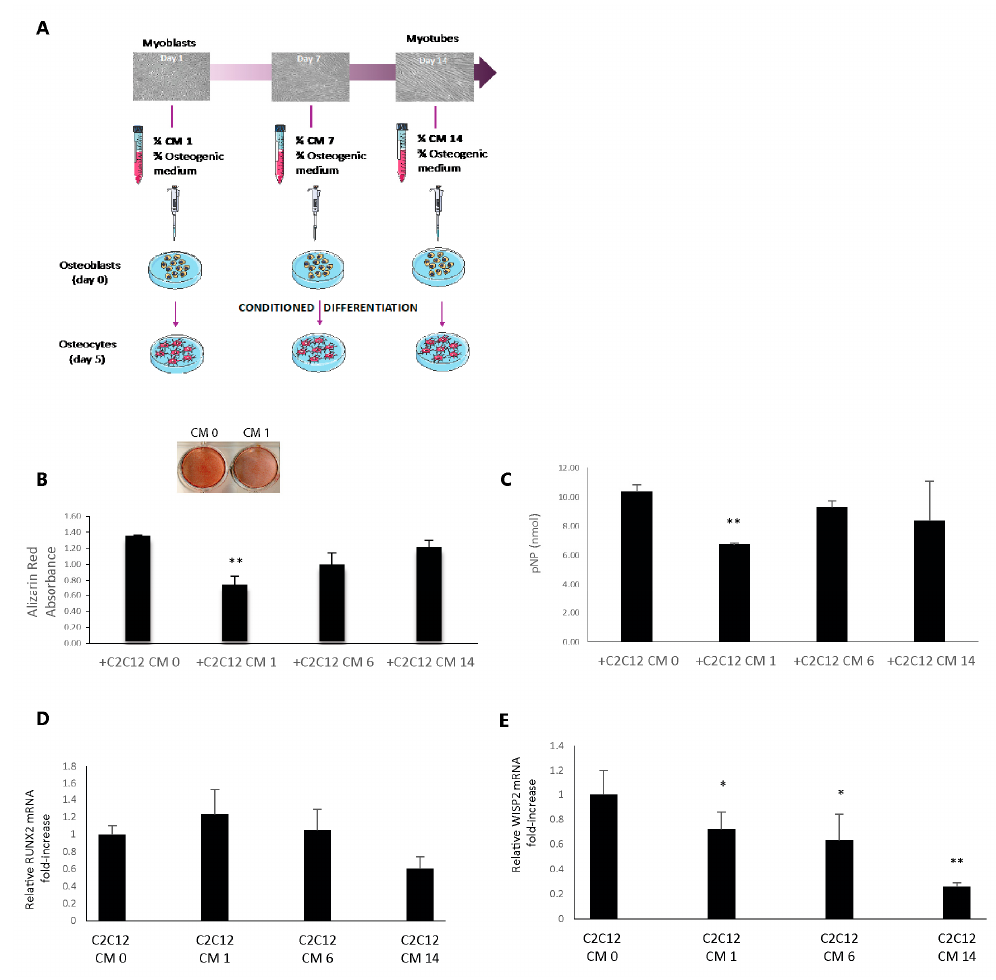
Figure 2. ( A ) Graphical scheme of the experimental workflow. A quarter of the medium obtained by C2C12 cells in cycling (CM0 used as reference) and in differentiating conditions (CM1–CM7–CM14) was added to three quarters of the osteogenic differentiating medium on 2T3 cells. Osteoblast cells were maintained in the differentiation medium for five days. ( B , C ) Alizarin Red staining and ALP assay of differentiated 2T3 cells conditioned with C2C12 media (CM0–CM1–CM6–CM14). Student’s t -test (vs. sample CM0) was applied with p < 0.05 (*) and p < 0.005 (**) ( D , E ) Messenger RNA was extracted from differentiated 2T3 cells and the relative expression of the osteogenic markers Runx2 and Wisp2 was evaluated. Statistical significance was obtained using one-way ANOVA + Dunnett’s post test vs. CM0.